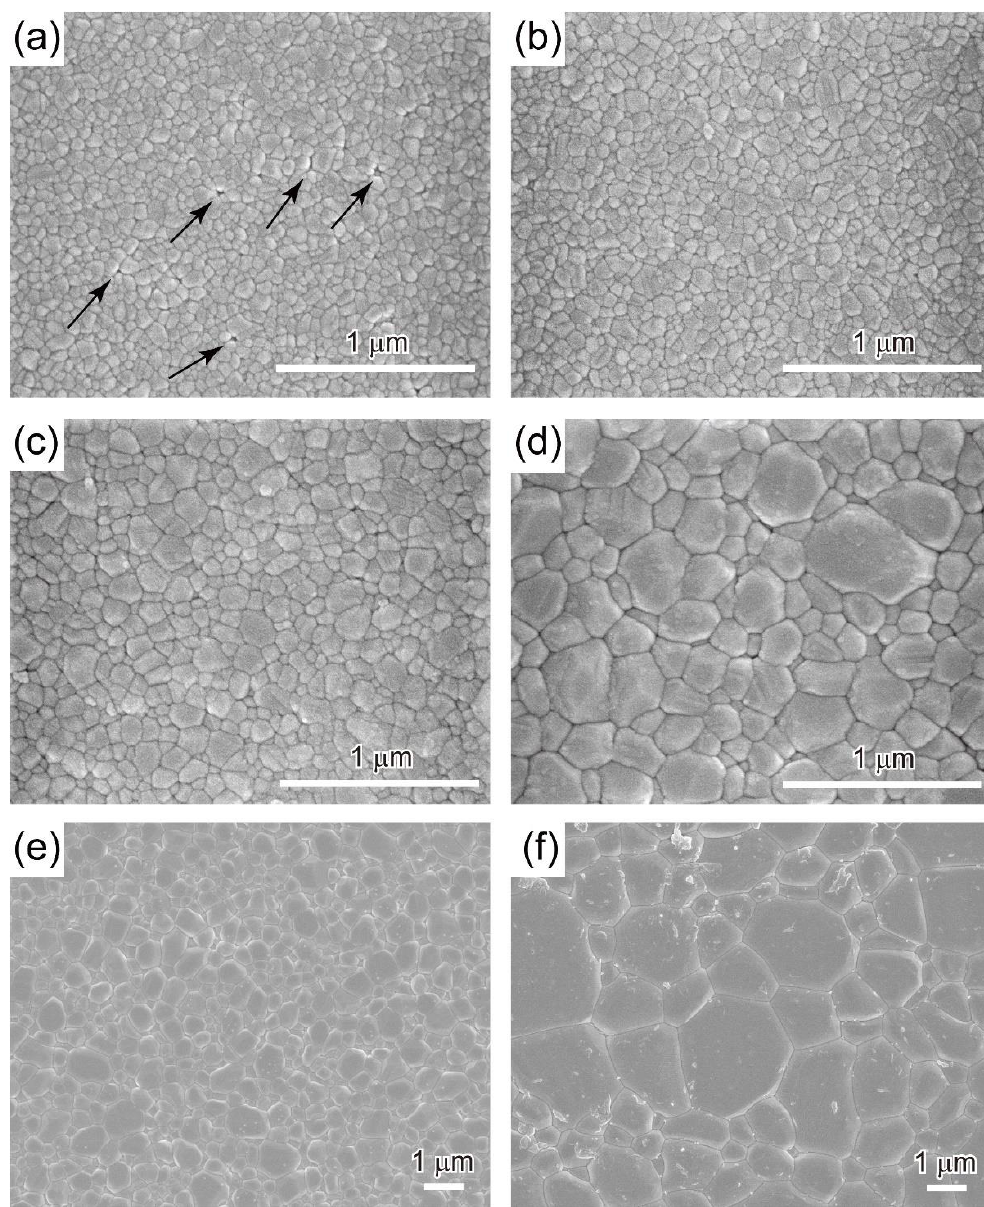
Figure 7. FE-SEM images of the polished surfaces of FAP ceramics sintered at ( a ) 900 °C, ( b ) 950 °C, ( c ) 1000 °C, ( d ) 1050 °C, ( e ) 1100 °C, and ( f ) 1200 °C.